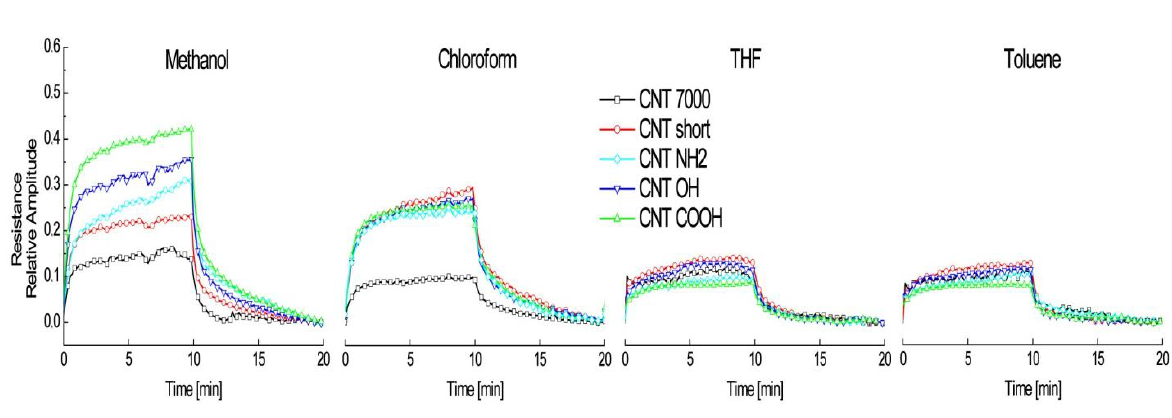
Figure 4. Responses of CNT sensors to methanol, chloroform, THF and toluene (standard set of volatile organic compounds